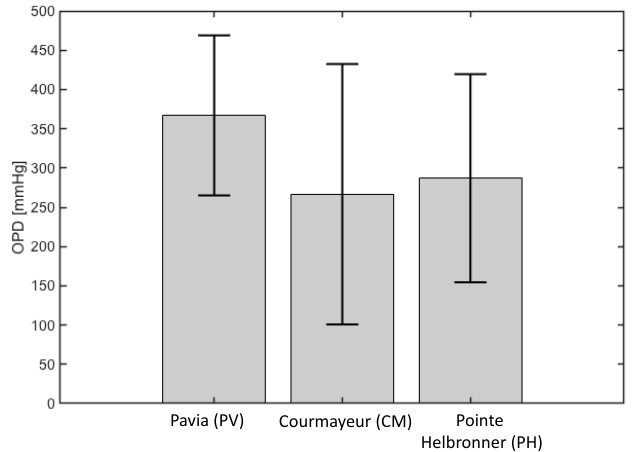
Figure 7. The physiology − enhanced aqueous humor analysis shows that a decrease in osmotic pressure difference (OPD) may underlie the difference in intraocular pressure measured at different altitudes. Attribution: Guidoboni, G.; Szopos, M.; Verticchio Vercellin, A.C.; Bruttini C.; Riva, I.; Siesky, B.A.; Harris A.; Quaranta L. Physiology-enhanced data analytics to evaluate the effect of altitude on intraocular pressure. Investigative Ophthalmology & Visual Science June 2021, Vol.62, 559 (Creative Commons Attribution-NonCommercial-NoDerivatives 4.0 International Public Li-